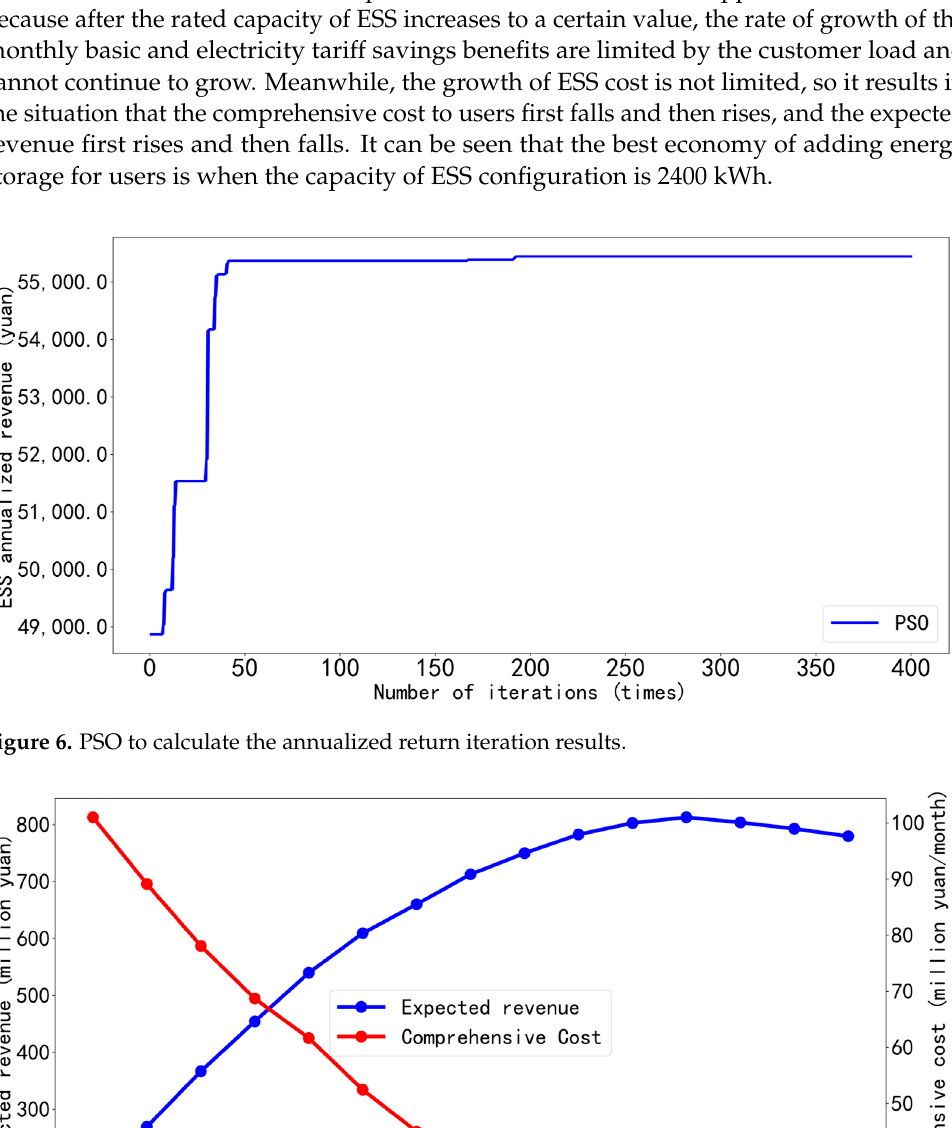
Figure 7. Impact of energy storage con fi guration on user income.